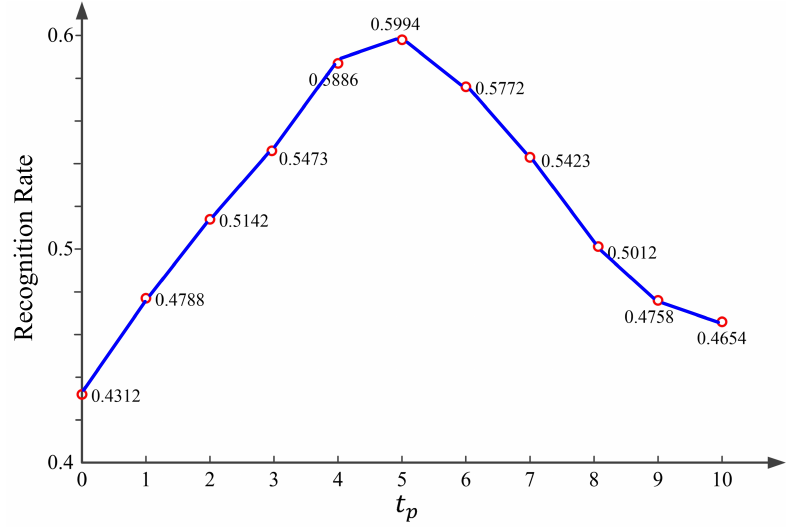
Figure 9. Recognition rates of the RLBP algorithm versus t p